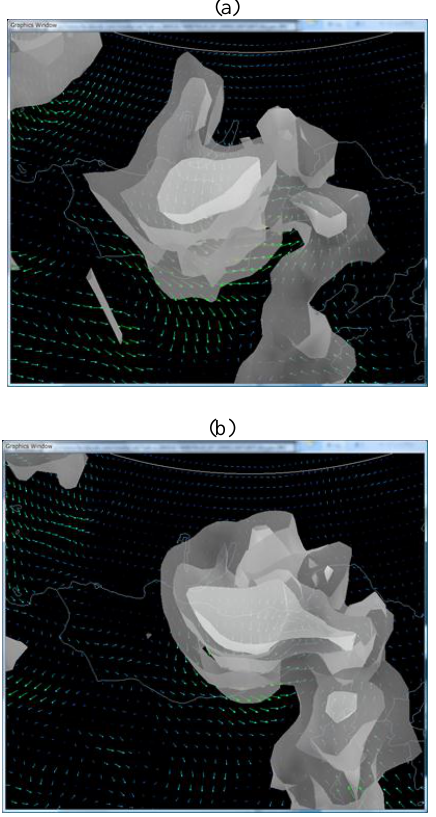
Fig.1 Flow of wind over the source region and isosurfaces of velocities of 10, 20, 25, 30 m/s. (a) shows equi-velocity surfaces at 2007.3.30 06:00 and (b) shows those at 2007.3.30 12:00.